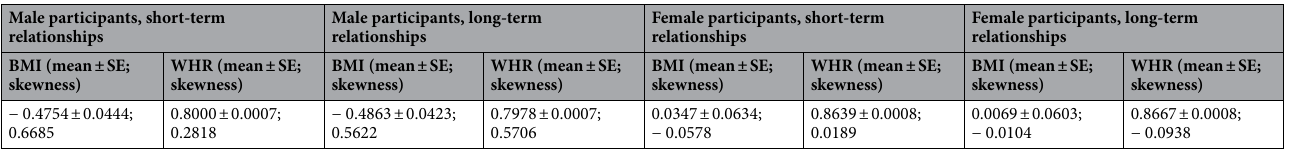
equality of variances between males and females’ WHR): for short-term relationships (females SD: 0.921; males SD: 0.890; F(143,182) = 1.071, p = 0.658) and for long-term relationships (females SD: 0.982; males SD: 0.883; F(143,182) = 1.238, p = 0.175). Moreover, distributions of BMI and WHR in females were more symmetric (has lower skewness; see Table 1) relative to those of males, that had higher skewness. There was no significant correlation between WHR and BMI for male participants in mate preference for short-term relationships (r = − 0.01, p = 0.89) or in long-term relationships (r = − 0.02, p = 0.77). There was a significant correlation between BMI and WHR for female participants in mate preference for short-term rela- tionships (r = 0.20, p = 0.02) and long-term relationships (r = 0.24, p = 0.003). Fisher’s r-to-z test for difference between correlations in male and female participants showed significant differences in a short-term relationship (z = 1.97, p = 0.05) and long-term relationship (z = 2.36, p = 0.019). Women preferred higher WHR in higher BMI figures. This indicated a gender-differential mate preference pattern, that men chose the most attractive WHR and BMI independently, while there was a small but significant positive correlation between the two for women.